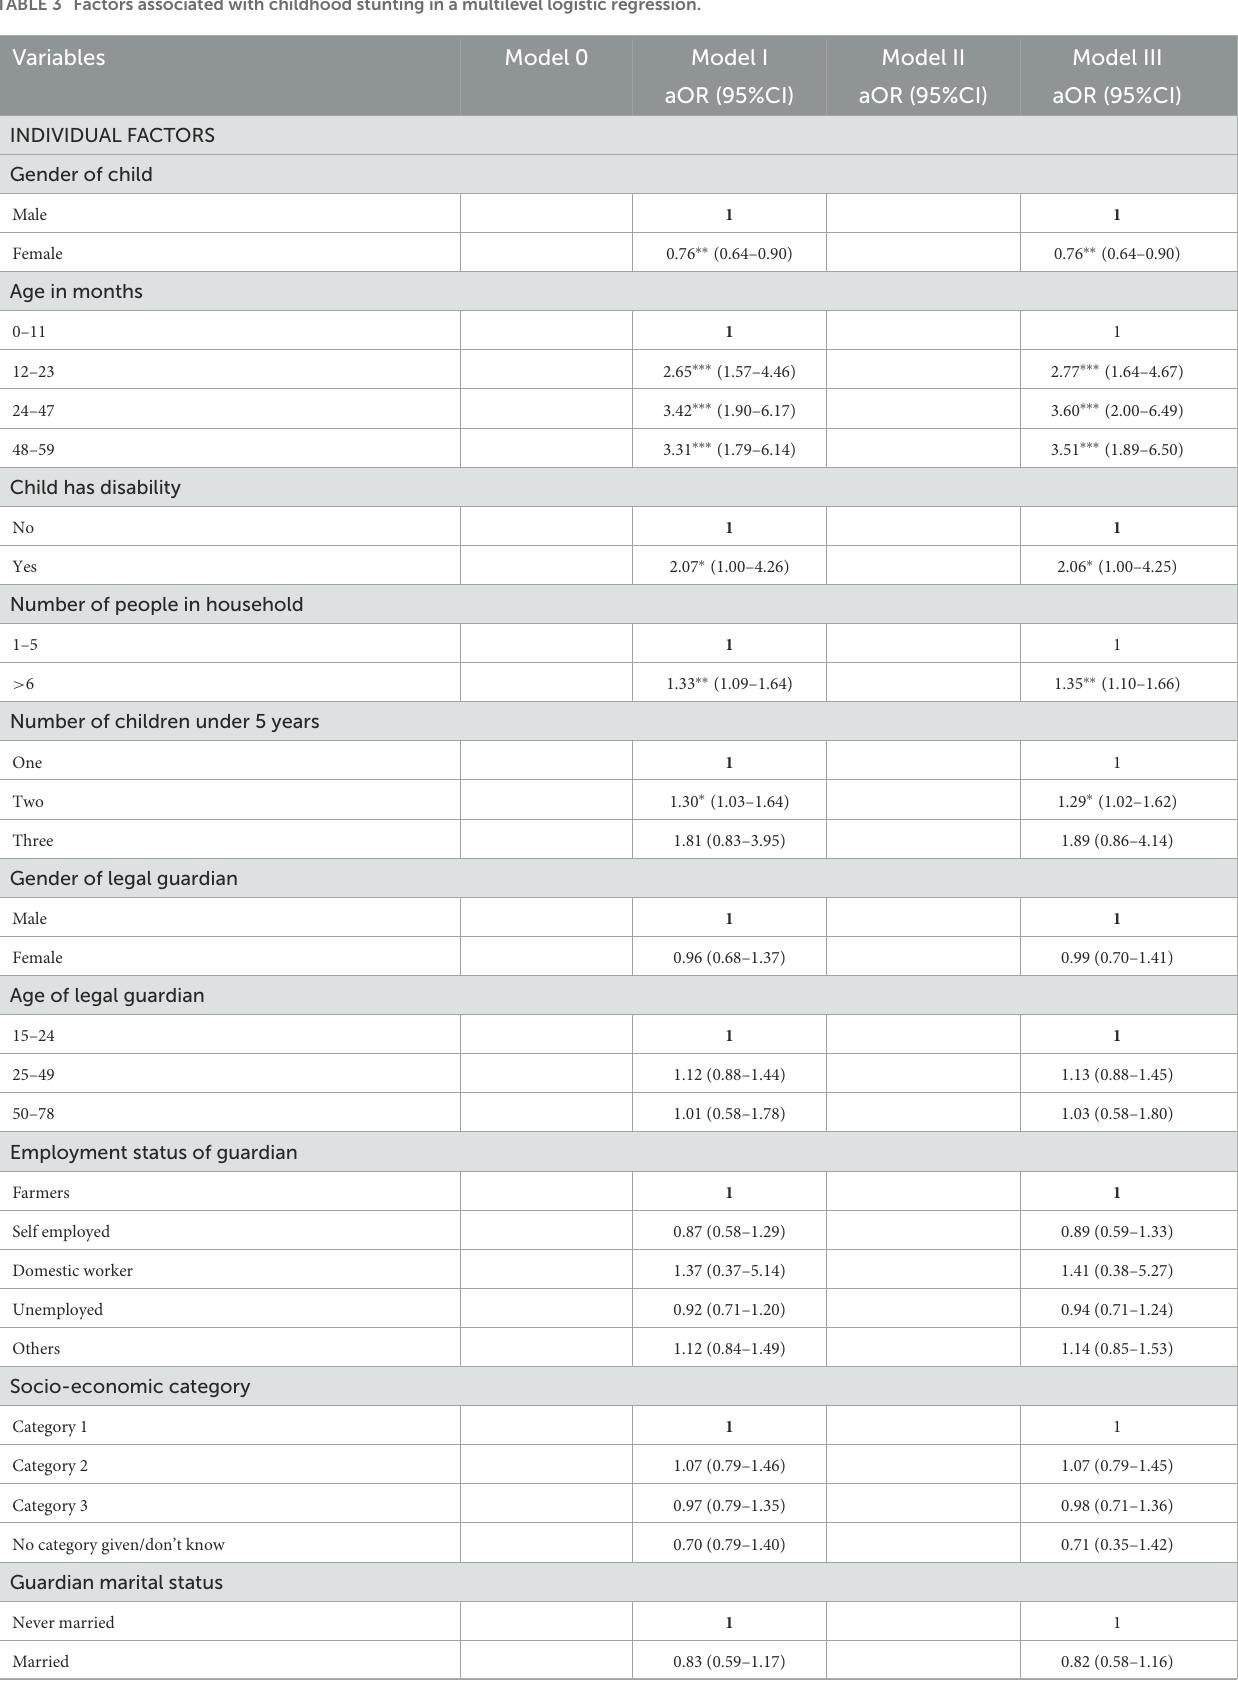
TABLE 3 Factors associated with childhood stunting in a multilevel logistic